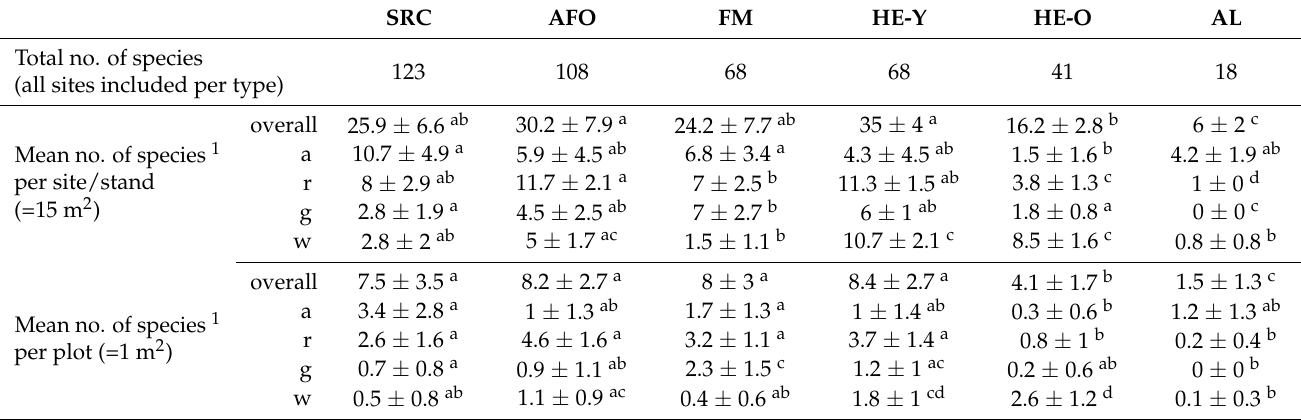
Table 3. Number of species (overall and separated by species of different habitat preferences) per habitat type (total number and mean ± SD per site/stand and per plot). Values with no consistent letter indicate significant differences ( p < 0.05). SRC